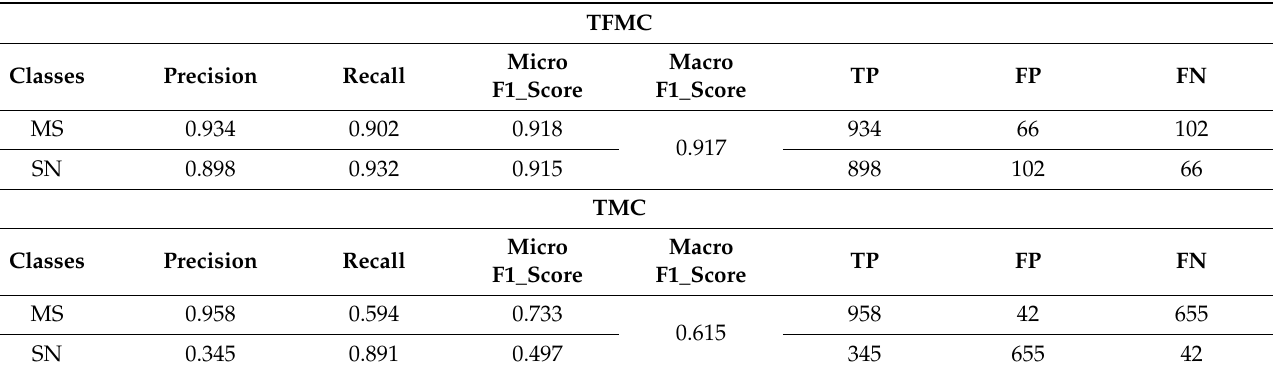
Table 10. Comparison between TFMC method and TMC method on the test dataset containing MS and SN.